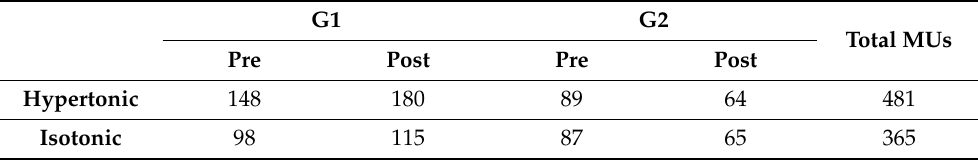
Table 1. Number of motor units (MUs) recognized during five isokinetic contractions, separated by groups and epochs in each injection protocol. The table shows the total motor units of the sample from each epoch above the accuracy cutoff of 80%.